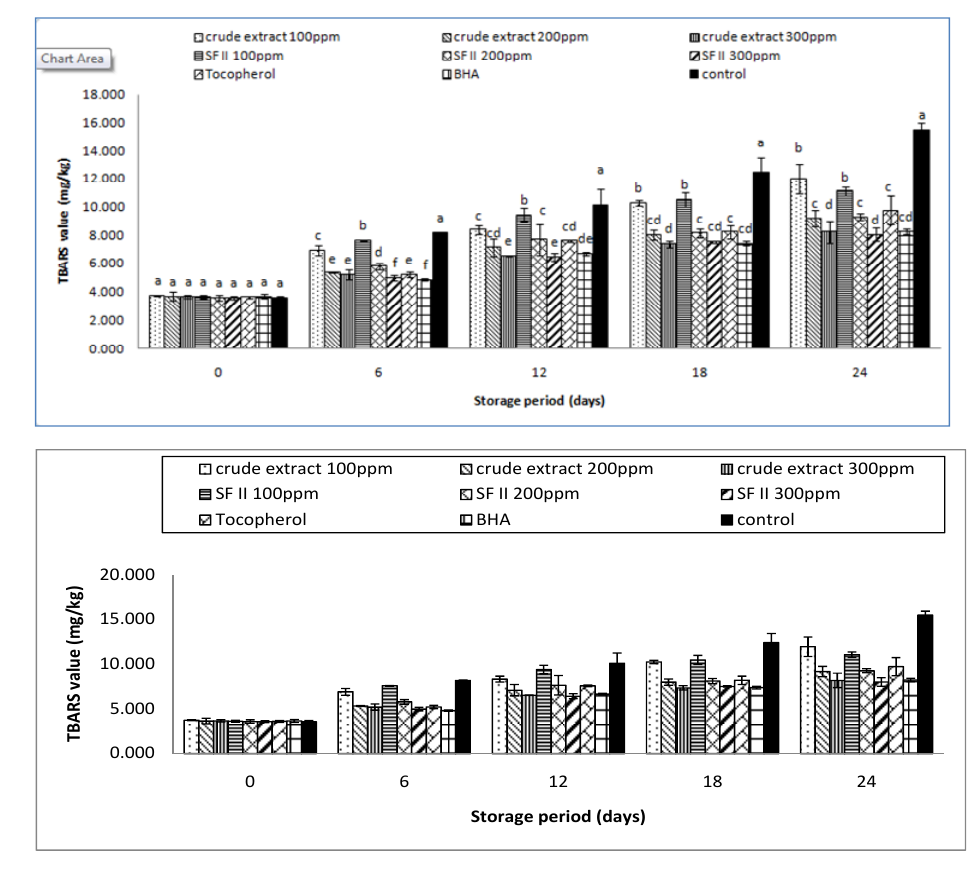
Figure 4. The thiobarbituric Acid Reactive Substances (TBARS) value of the supplemented sunflower oil with rambutan extracts, BHA and tocopherol under accelerated storage at 65 °C for 24